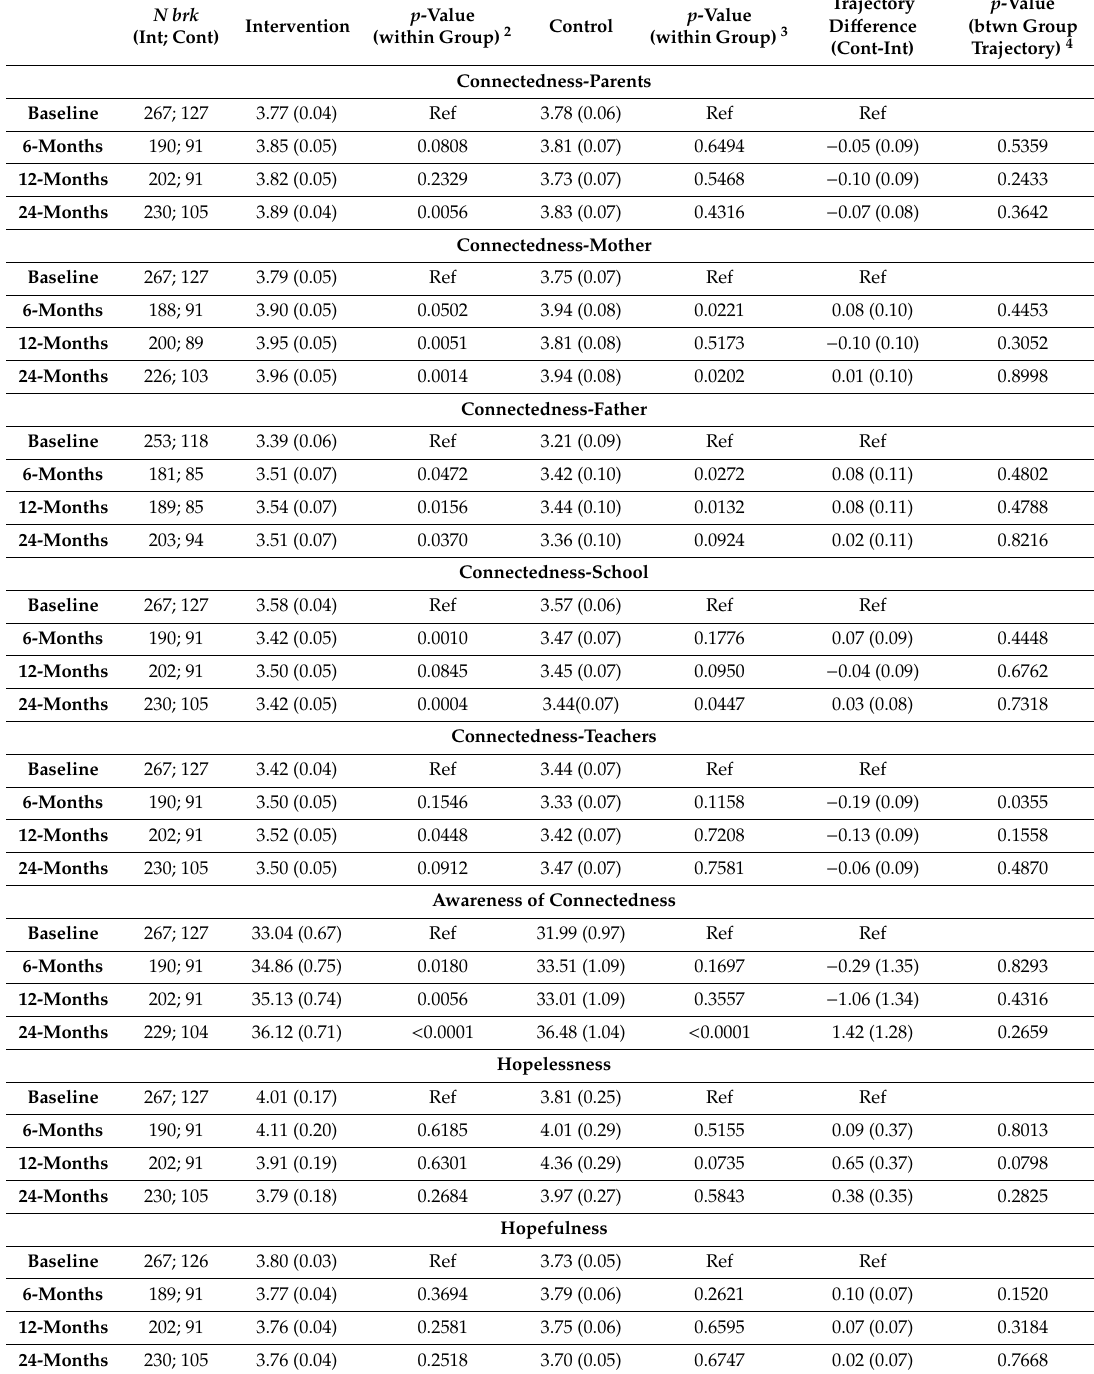
Table 3. Social well-being outcomes 1